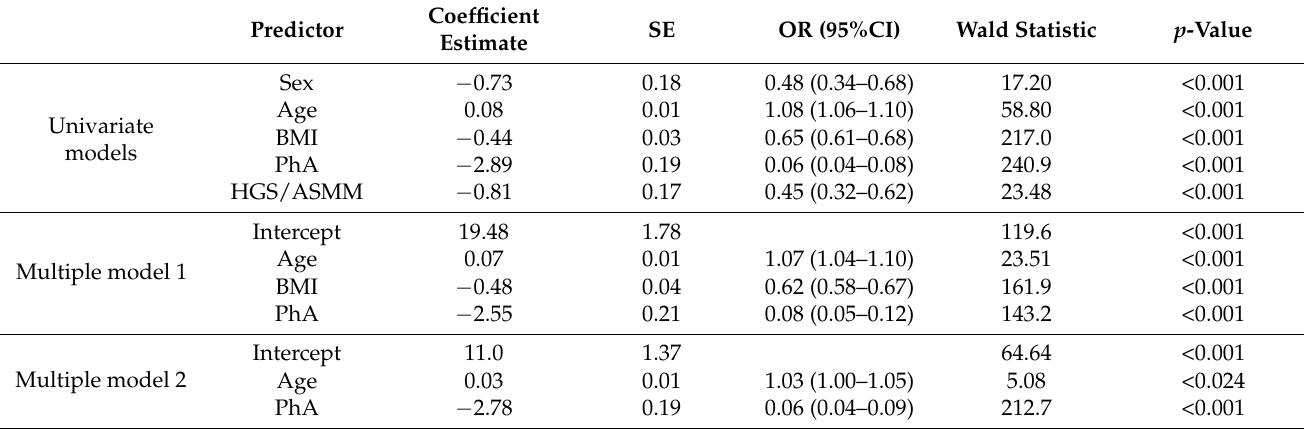
Sex: men = 1, women = 0; BMI—body mass index, PhA—phase angle; SE—standard error; OR—odds ratio; 95% CI—confidence